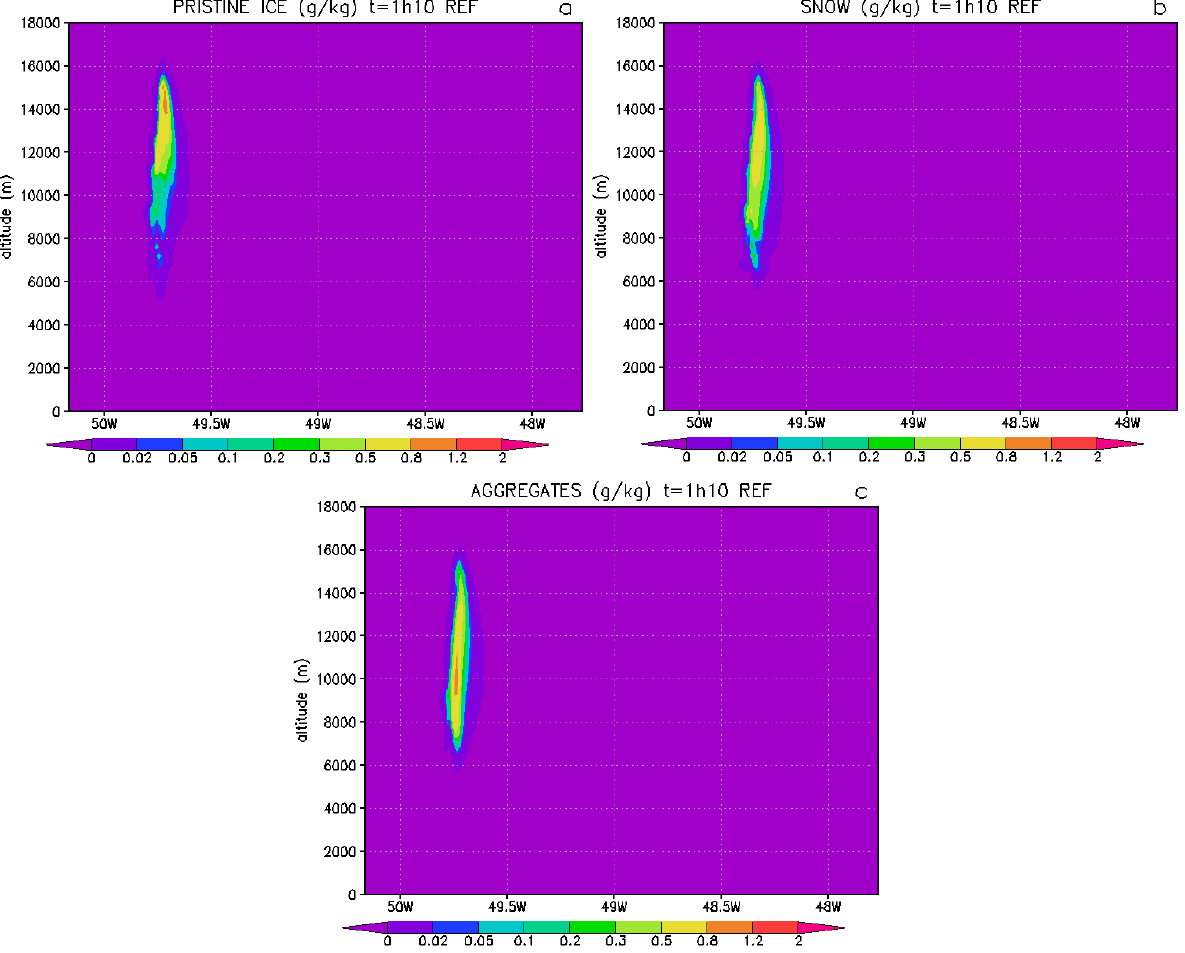
Fig. 1. Vertical cross-sections from surface to 18 km height within the convective cloud from the REF simulation. Panels (a, d, g) , panels (b, e, h) and panels (c, f, i) correspond respectively to the mixing ratio of pristine ice, of snow. and of aggregates. Panels (a, b, c), panels (d, e, f) and panels (g, h, i) are respectively for 01:10, 02:00 h and 03:30 after the beginning of the